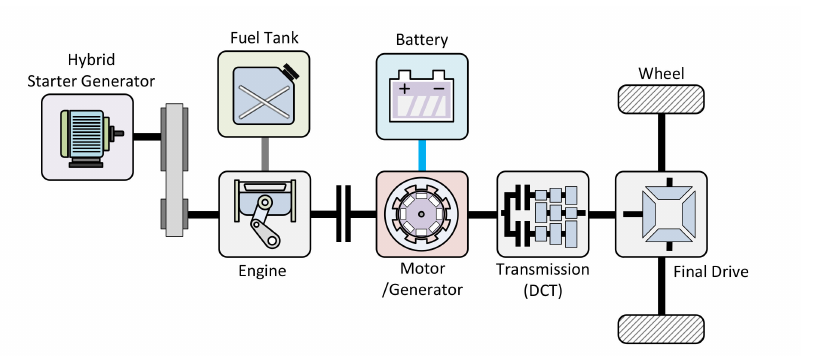
Figure 1. Parallel Hybrid System Configuration.